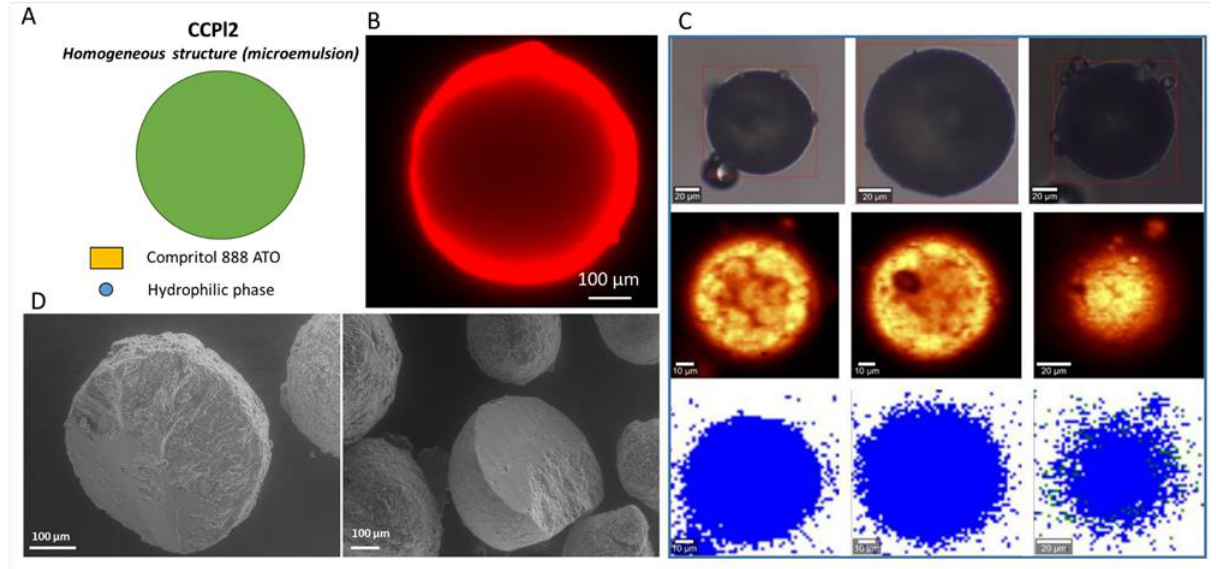
Figure 9. Internal morphology of CCPl2 b-MPs. Schematic illustration of particle structure ( A ). CLSM images, Rho (red color) solubilized in the hydrophilic phase was used as a fluorescent probe ( B ). Raman mapping images. The first row (at the top) shows visible pictures; the second row shows Raman images obtained based on the integration of characteristic Raman bands at 2852 and 2886 cm − 1 ; the third row shows Raman images: lipophilic phase (blue area) and hydrophilic phase (green area) ( C ). SEM images of cross-sections of CCPl2 b-MPs ( D ).